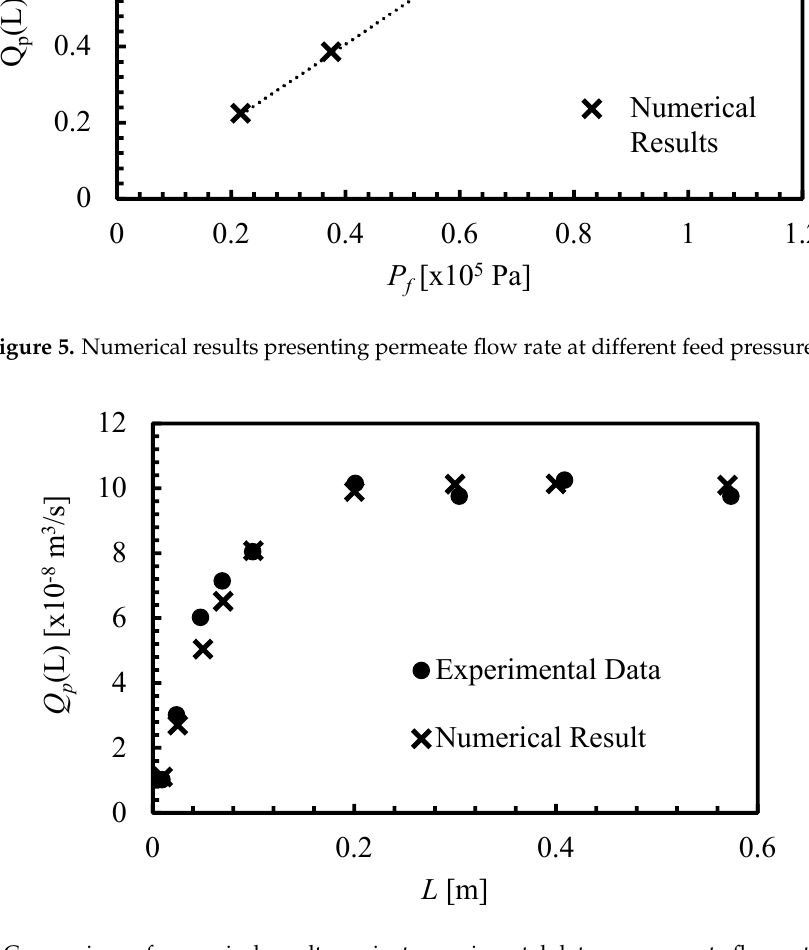
Figure 6. Comparison of numerical results against experimental data on permeate flow rate of fibres with different length.